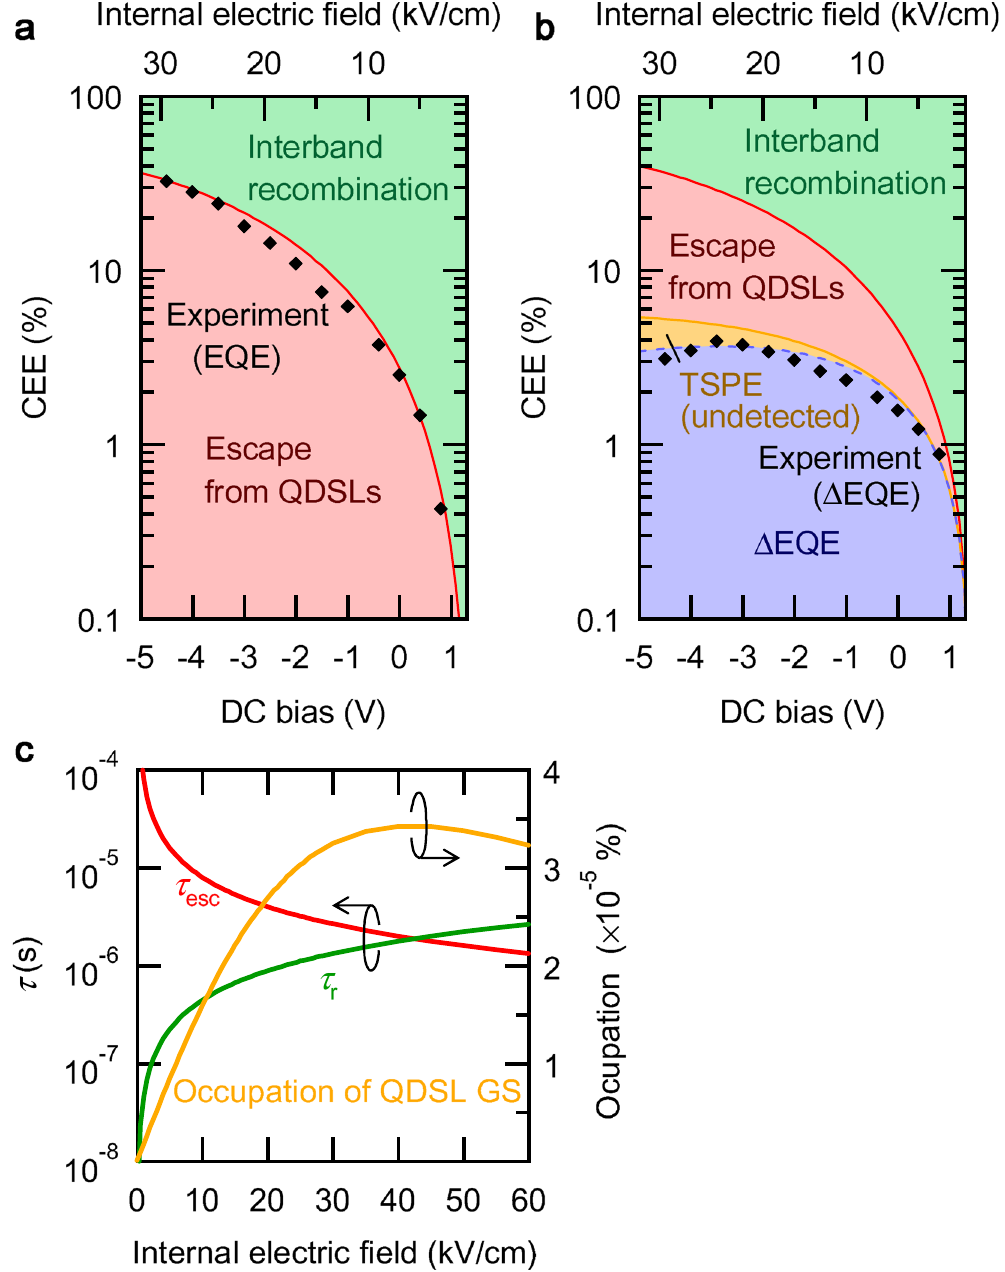
Figure 6. Calculated carrier-extraction efficiency for carriers generated by the interband photoexcitation at 950 nm. ( a ) and ( b ) show the results obtained without and with the intersubband excitation, respectively. The solid symbols indicate the experimental results normalised by the interband photoexcited carrier density at 950 nm. ( c ) summarises the evaluated time constants a function of the internal electric